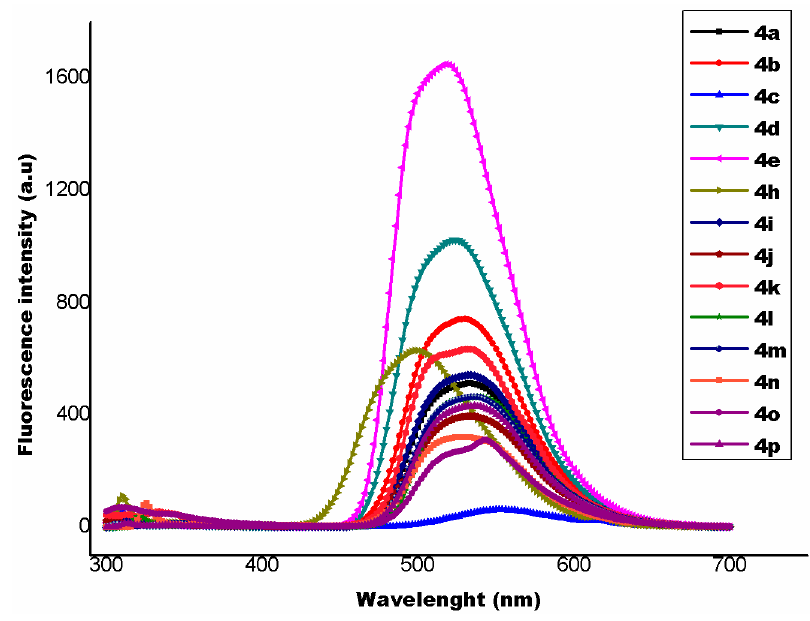
Figure 4. Fluorescence emission spectra the compounds 4 ( a – p ).